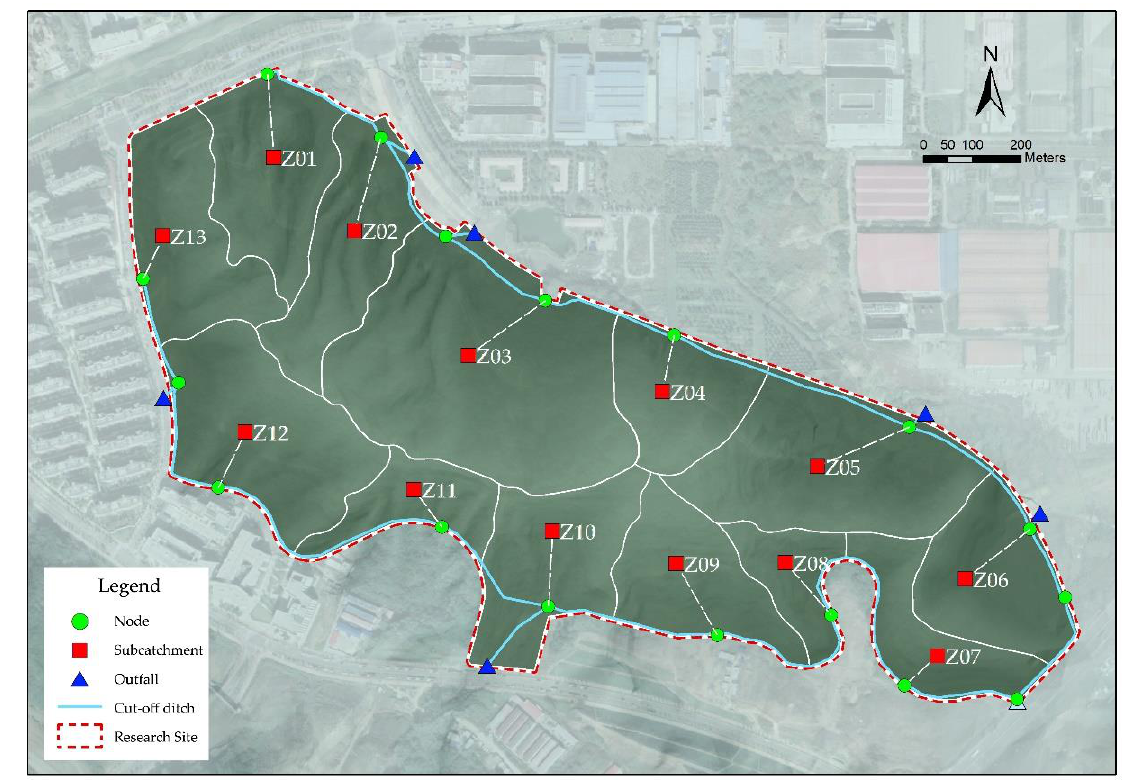
Figure 3. Subcatchment Partitions and Model Generation Pre-LID Schemes.